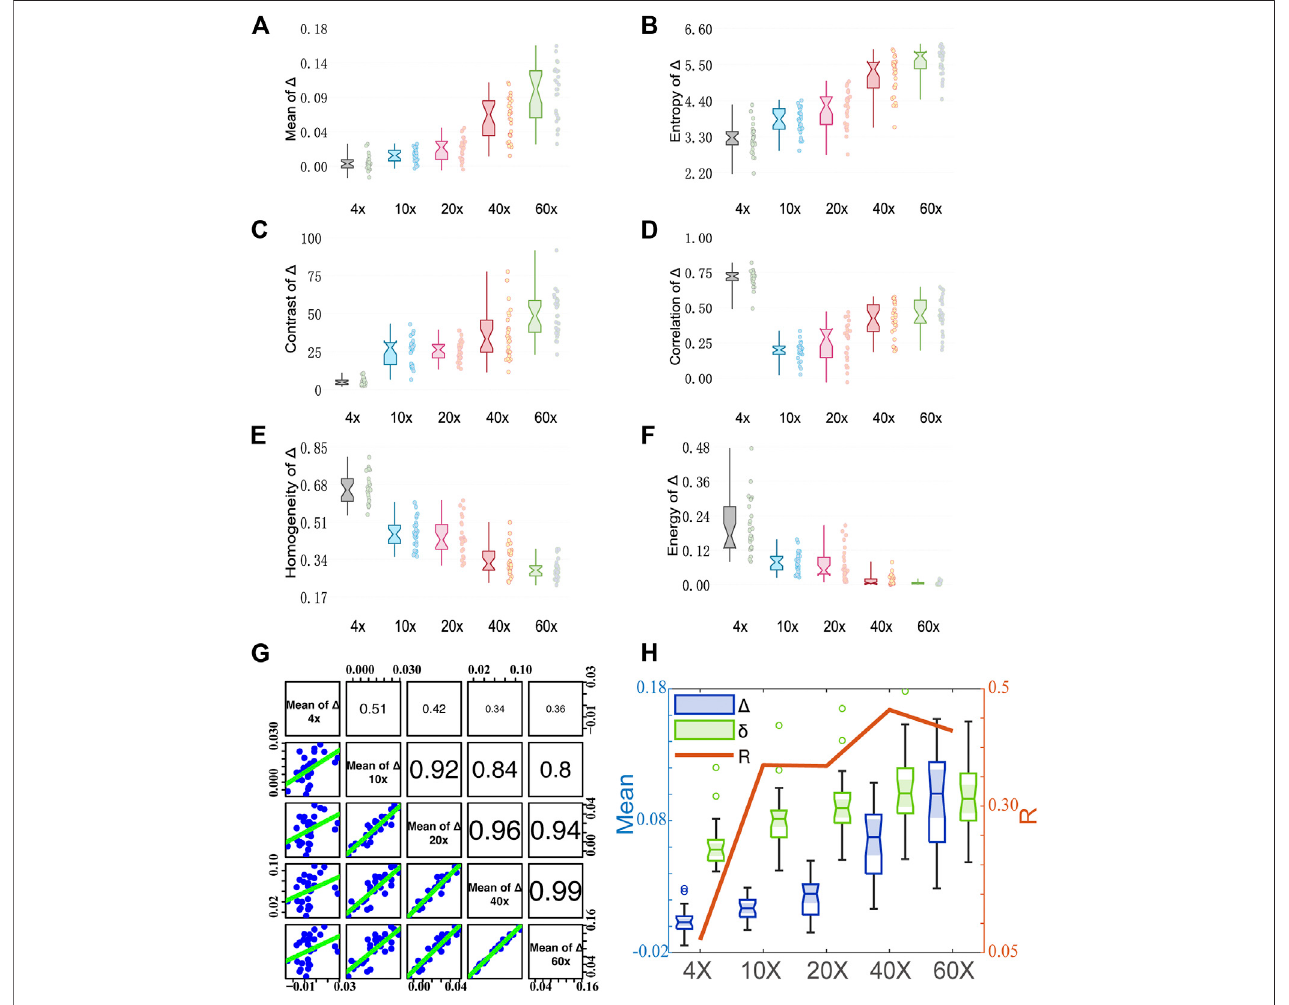
FIGURE 5 | Quantitative analysis results of MMPD parameter Δ images under different magni fi cation objectives (4×/NA 0.10, 10×/NA 0.25, 20×/NA 0.40, 40×/NA 0.65, and 60×/NA 0.80). (A – F) Box plots of Mean, Entropy, Contrast, Correlation, Homogeneity, and Energy. (G) The Correlation coef fi cient R between two pairs of the mean of Δ at different magni fi cation objectives. (cf. Figure 3I ). (H) The Correlation coef fi cient R between the mean of Δ and δ .